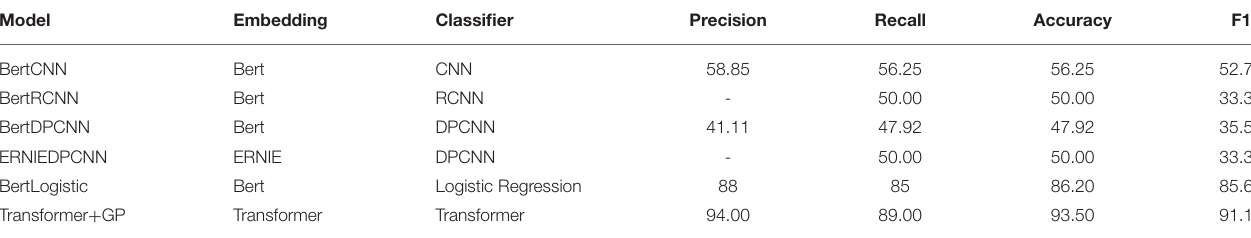
TABLE 3 | The result of pre-trained models on Pitt dataset.